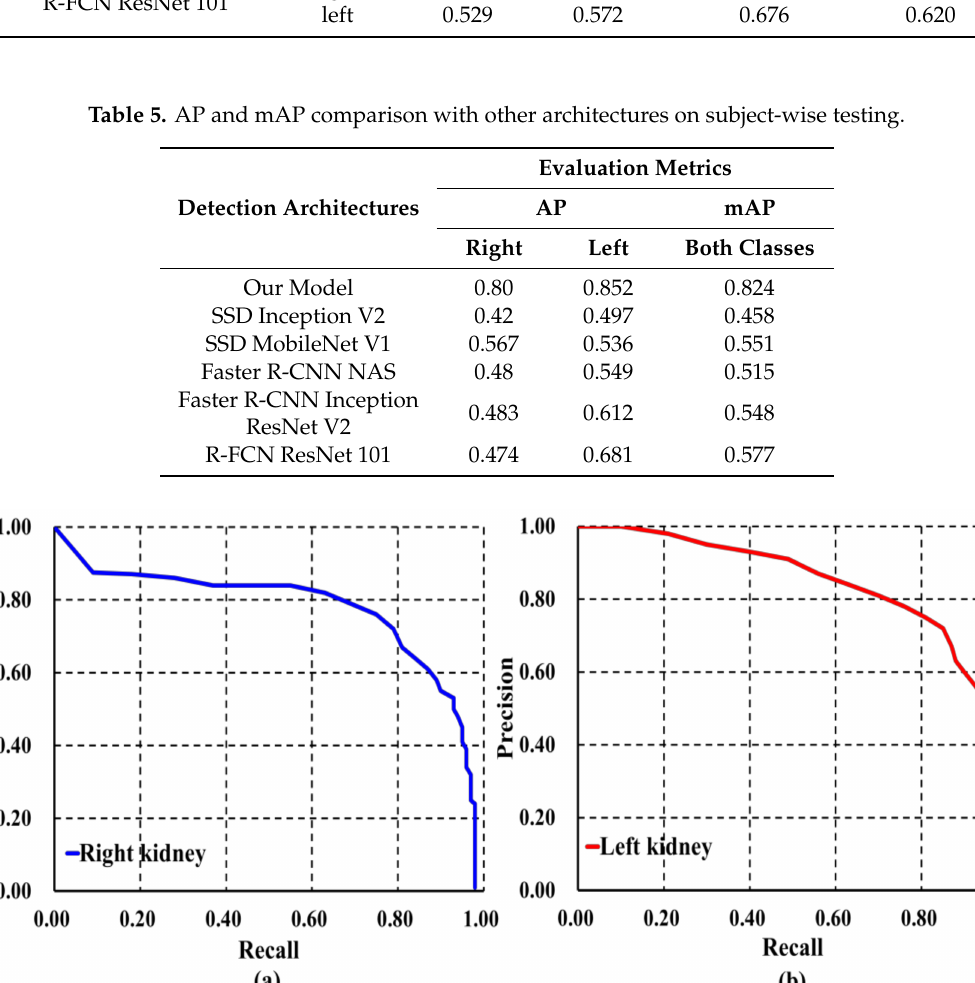
Figure 9. Precision-recall curve of our model on subject-wise testing: ( a ) Right kidney; ( b ) Left